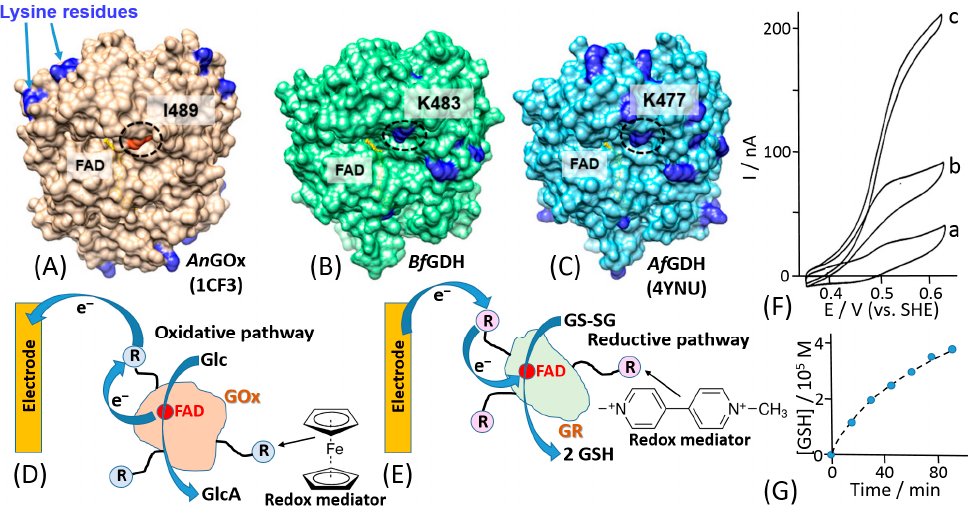
Figure 4. ( A – C ) Comparison of the positions of lysine residues in Aspergillus niger derived glucose oxidase ( An GOx) (PDB ID: 1CF3), Botryotinia fuckeliana derived glucose dehydrogenase ( Bf GDH) (model), and A.flavus derived GDH ( Af GDH) (PDB ID: 4YNU). Lysine residues are shown in dark blue. In Bf GDH and Af GDH, lysine residues (K483, K477, circled) are located at the entrance of what appears to be a pathway to the active center. In An GOx, an isoleucine residue (I489, circled) is located at this position. ( D ) The electron transfer from soluble GOx to a Au electrode mediated by ferrocene redox relay (R) species covalently tethered to the enzyme with long flexible chains. Note that ferrocene has a positive redox potential needed to mediate the oxidative biocatalytic process. The biocatalytic reaction results in glucose (Glc) oxidation and gluconic acid (GlcA) formation. ( E ) The electron transfer from a Au electrode to soluble glutathione reductase (GR) mediated by viologen redox relay species covalently tethered to the enzyme with long flexible chains. Note that viologen has a very negative redox potential needed to mediate the reductive biocatalytic process. The biocatalytic reaction results in transformation of the oxidized glutathione (GS-SG) to the reduced glutathione (G-SH). ( F ) Cyclic voltammograms obtained with a bare (unmodified) Au electrode (a disk of 1.5 mm diameter) measured in the presence of a ferrocene-functionalized GOx (12 ferrocene electron relays per a GOx molecule, shown schematically in ( D ); 10 mg / mL): (a) in the absence of glucose; (b) and (c) in the presence of 0.8 mM and 5 mM glucose, respectively. A phosphate bu ff er solution (0.085 M, pH 7.0) was used as a background electrolyte applied under N 2 atmosphere. Scan rate was 2 mV / s. ( G ) Formation of reduced glutathione bioelectrocatalyzed by GR functionalized with viologen mediator units tethered to the enzyme with long flexible chains (see experimental details in [48]. (Part A is adopted from ref. [46] with permission; part F is adopted from [20] with